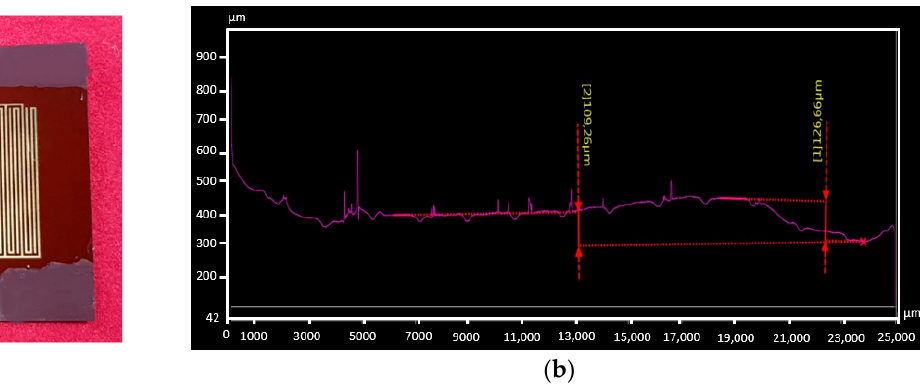
Figure 4. ( a ) The fabricated sensor with EB-PEI-coated and bare resonators. ( b ) The measured EB-PEI thickness.